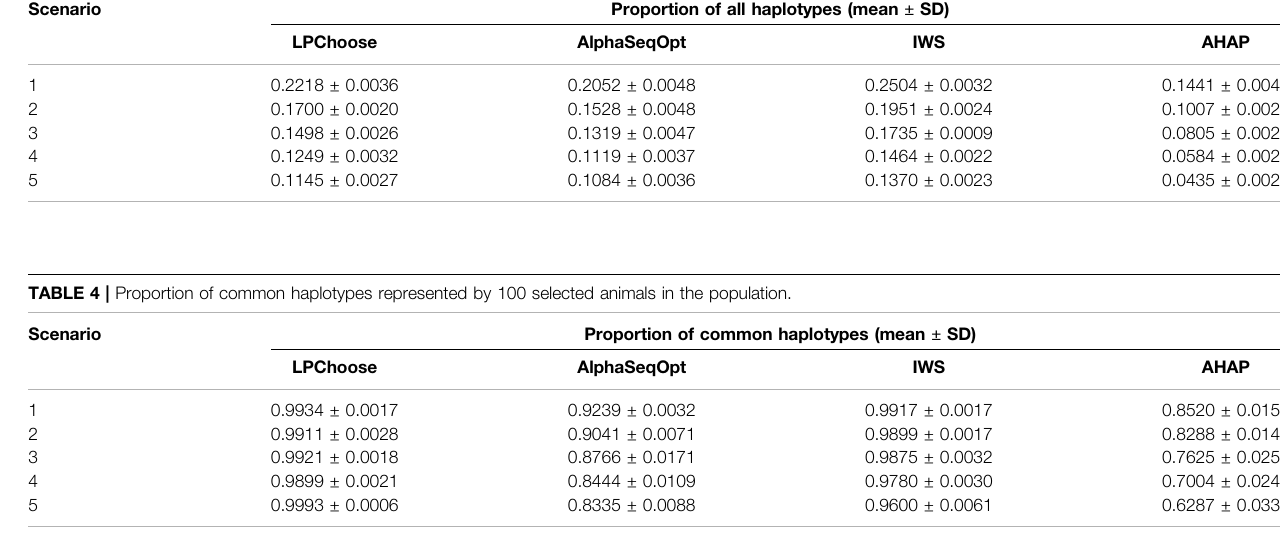
TABLE 3 | Proportion of all haplotypes represented by 100 selected animals in the population. Scenario